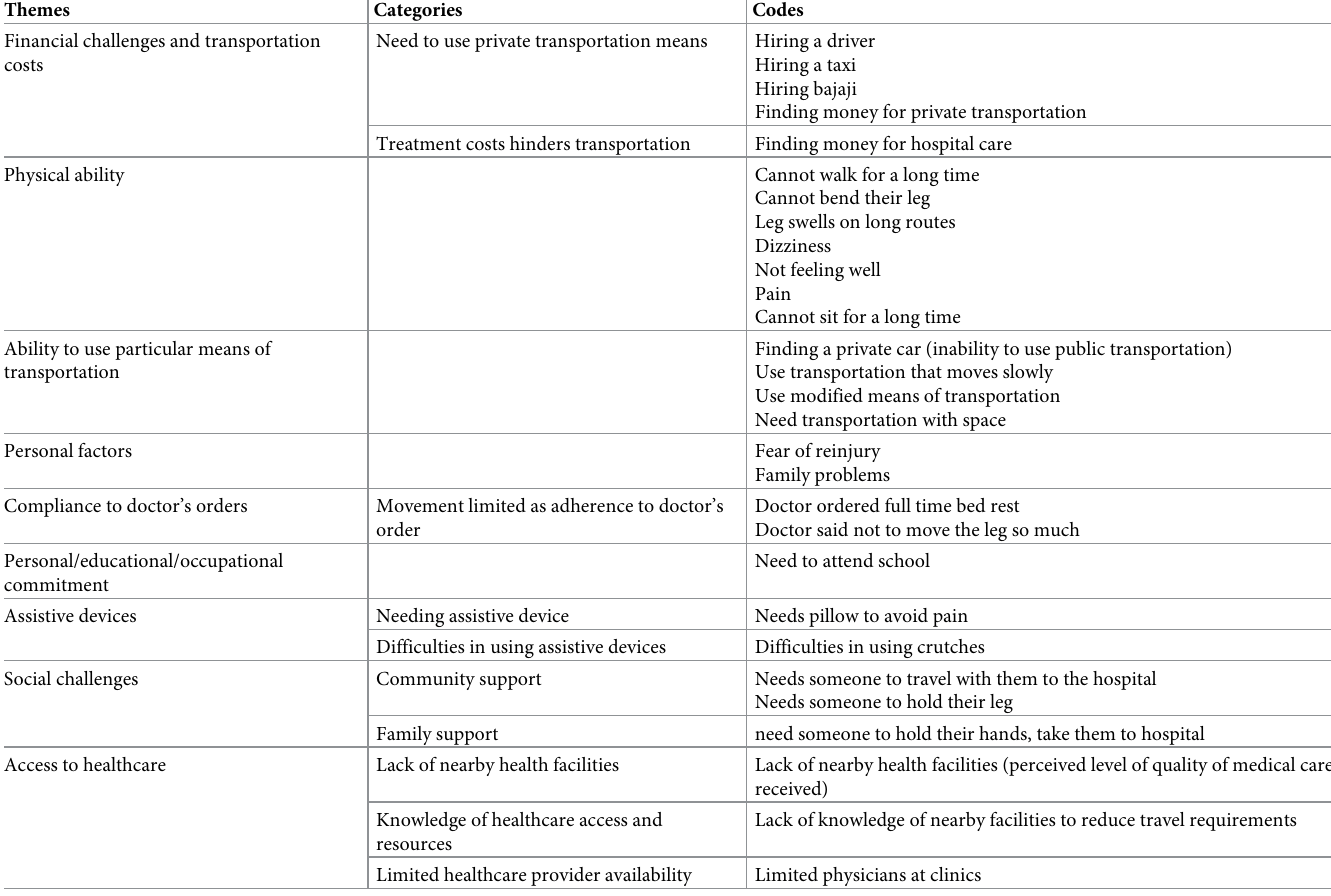
Table 3. Qualitative barriers to transportation after